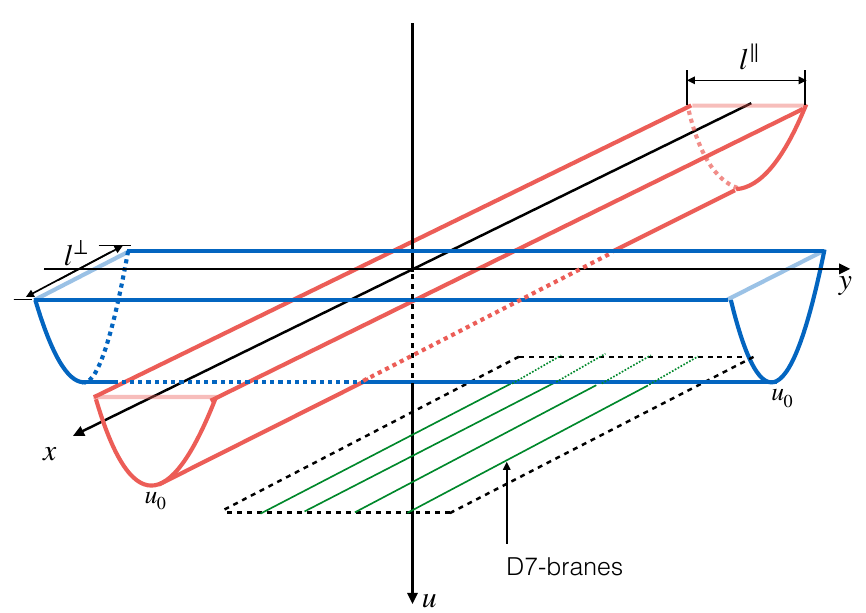
Figure 5 . Surface stretched into the anisotropic bulk geometry. The red and blue case refers to that the slab is parallel and perpendicular to the D7-branes respectively. The D7-branes are denoted by the green